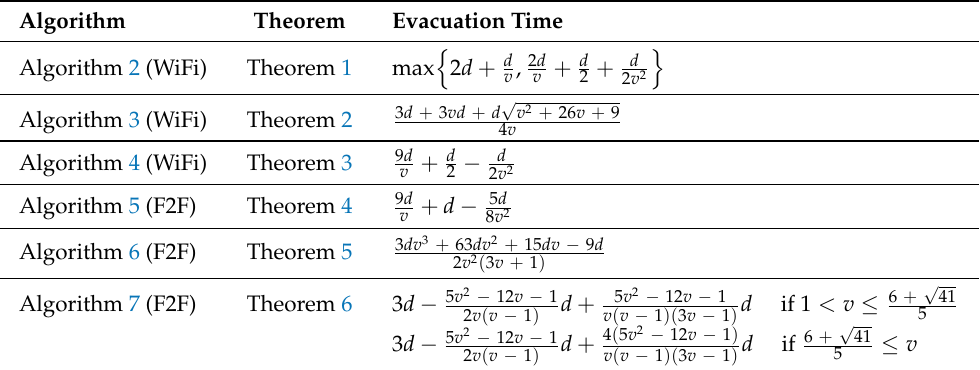
Table 1. Main algorithms presented in the paper in the WiFi (top three) and Face-to-Face (F2F) (bottom three) models, the theorem where the analysis, and their corresponding evacuation time as a function of the bike’s speed v , where v >